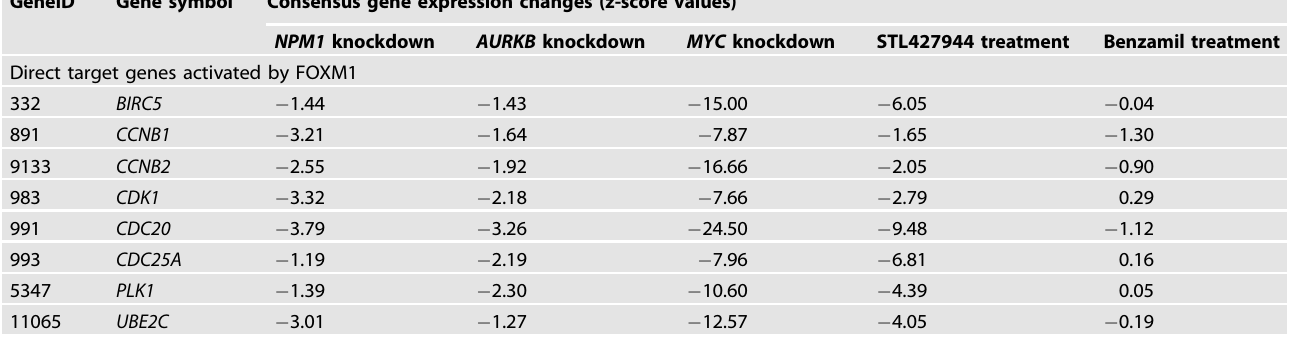
Table 1. Changes in expression of FOXM1-associated genes across a set of human cancer cell lines (LINCS data) caused by NPM1 , AURKB , and MYC knockdown or treatment with candidate FOXM1-inhibiting